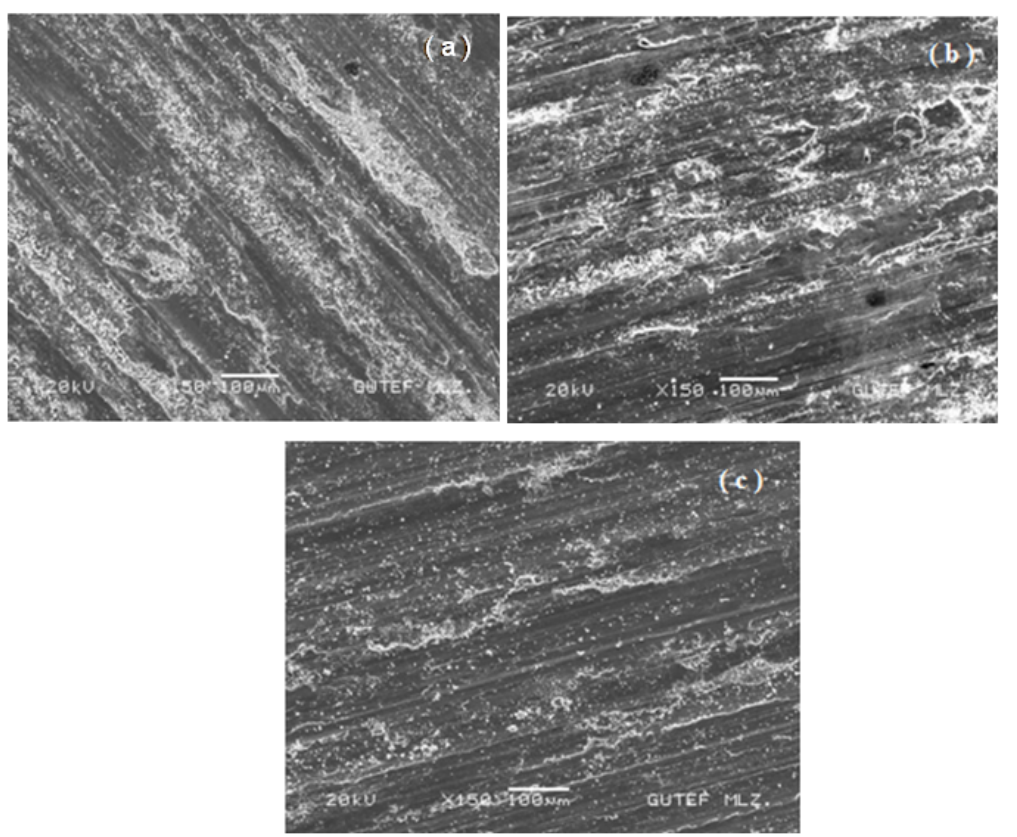
Figure 7. SEM images of the worn surfaces under 45 N load and 2000 m sliding distance (a) Sponge Titanium, (b) Tita- nium powder and (c) Ti6Al4V